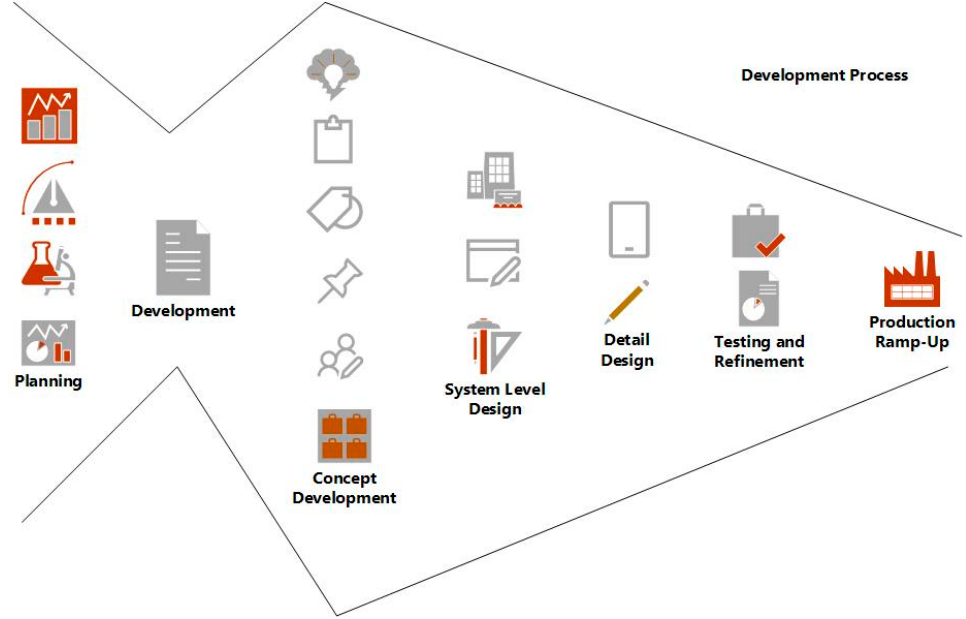
Figure 1. A generic product development process.